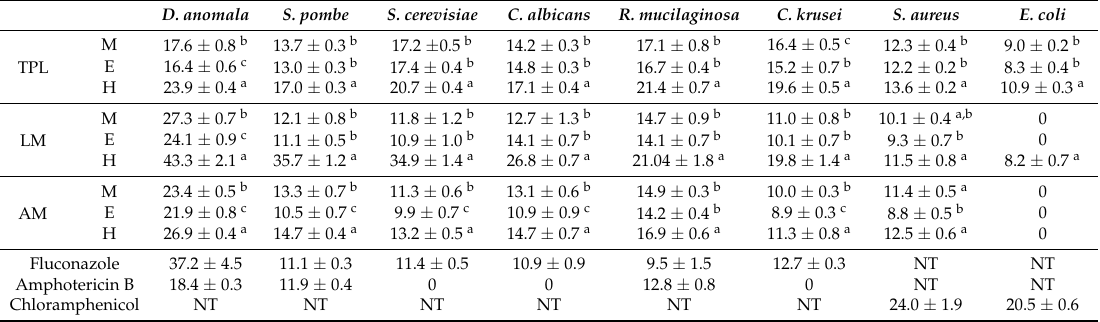
Table 2. Inhibition zone (mm) of Australian native herb extracts from hexane, methanol and ethanol against yeasts and